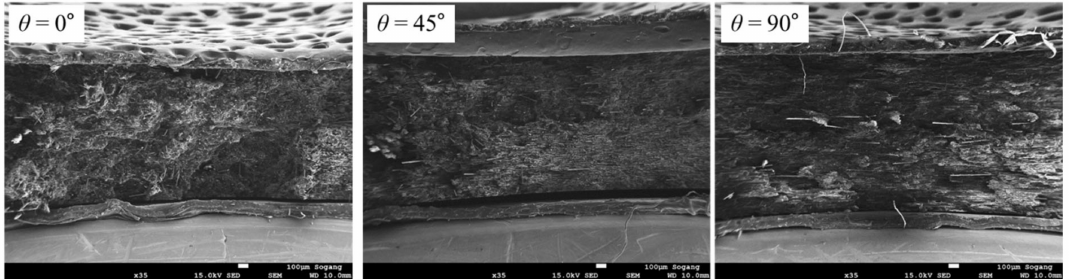
Figure 9. Fracture faces observed from tensile specimens which were tested with a strain rate of 0.001 s − 1 (magnification: × 35, scale: 100 µ m).